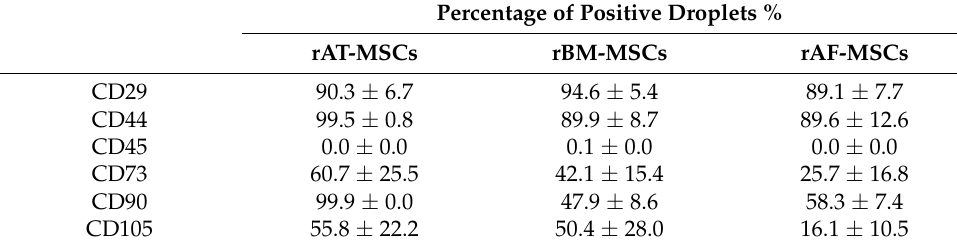
Table 6. Expression of surface markers using ddPCR.